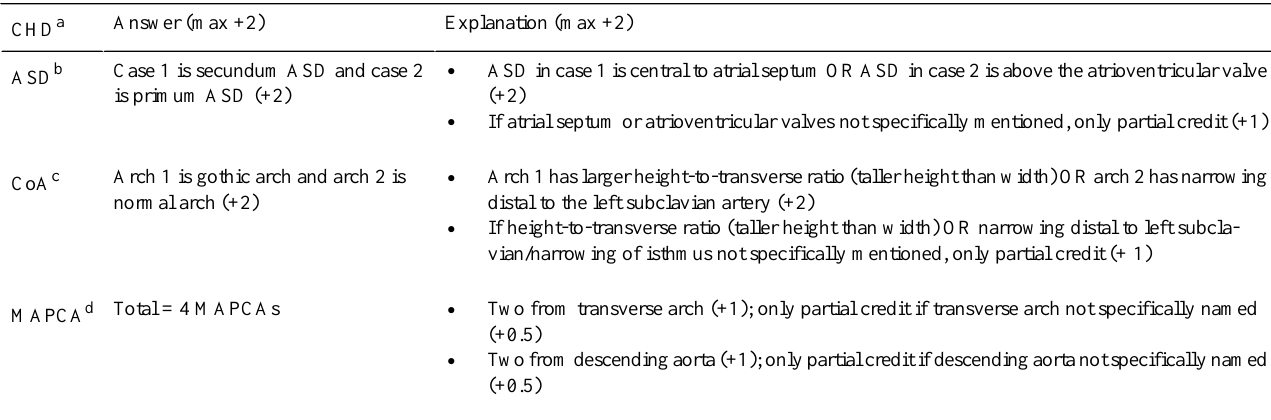
Table 3. Grading rubric of the diagnostic questionnaires used in the